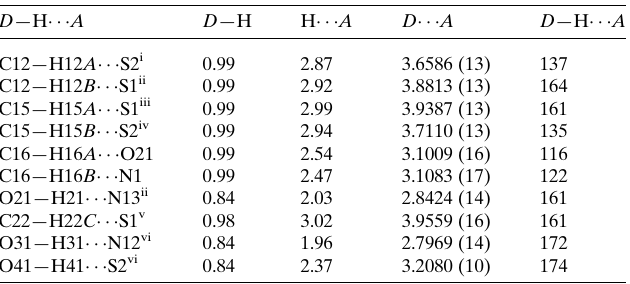
Table 4 Hydrogen-bond geometry (A˚ , (cid:5) ) for 2 .